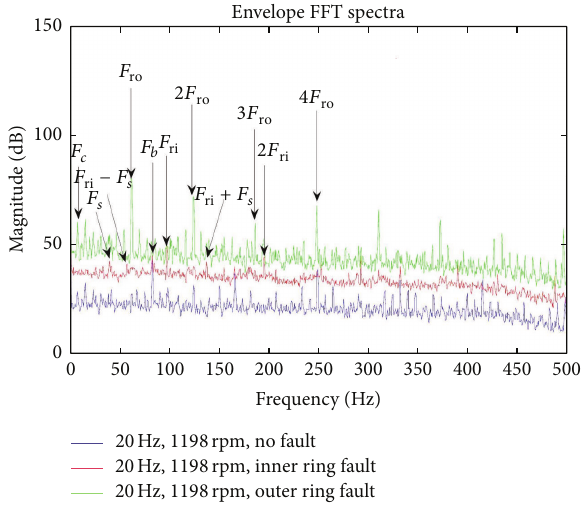
Figure 8: Nominal, inner defect, and outer defect spectra of 20 Hz motor input, free load condition, and axial vibration measurements.